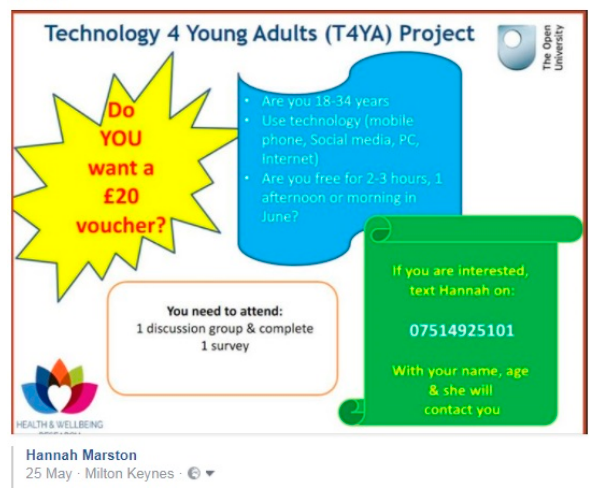
Figure 2. The amended poster and its deployment via Facebook for participant recruitment.